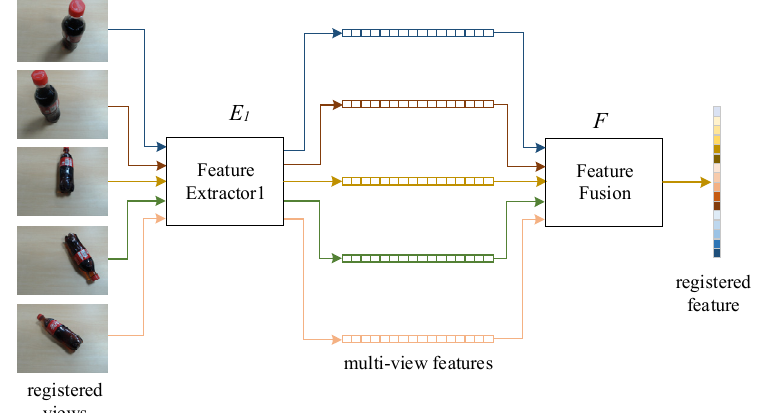
Figure 5. Architecture of the registering module of MVRFFNet.